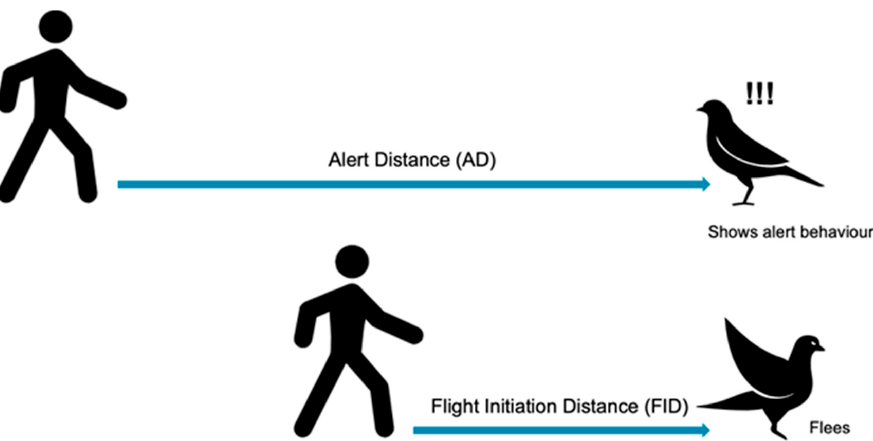
Figure 1. Graphical representation showing the bird alert distance (AD) and flight initiation distance (FID).